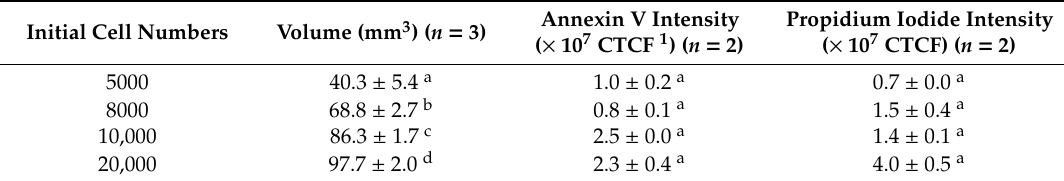
Table 1. Five-day-old SK-MEL-2 spheroid volume and cell death fluorescence intensity. Di ff erent letters in the same column indicate significant di ff erences between samples ( p <